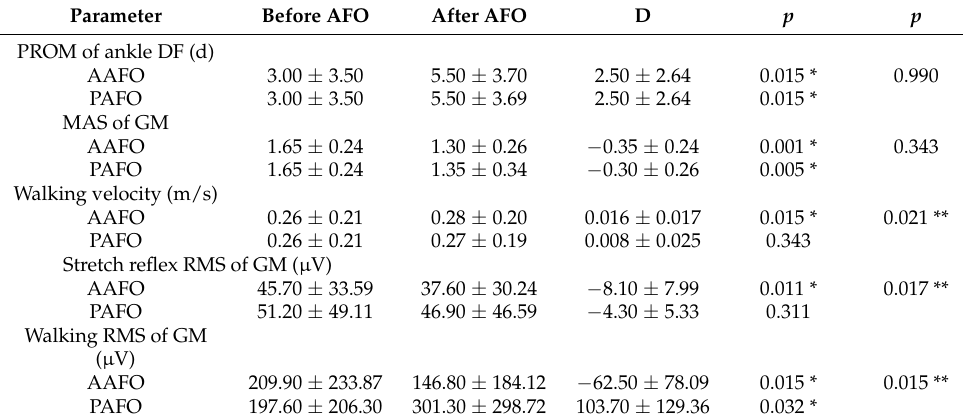
Table 1. Comparison between AAFO and PAFO.